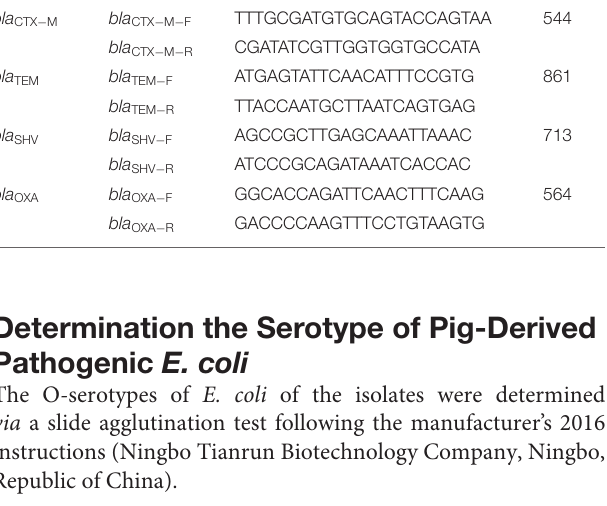
TABLE 2 | The resistant phenotype of 67 pathogenic E. coli isolates. Multiple Resistant phenotype Strain antibiotic resistance